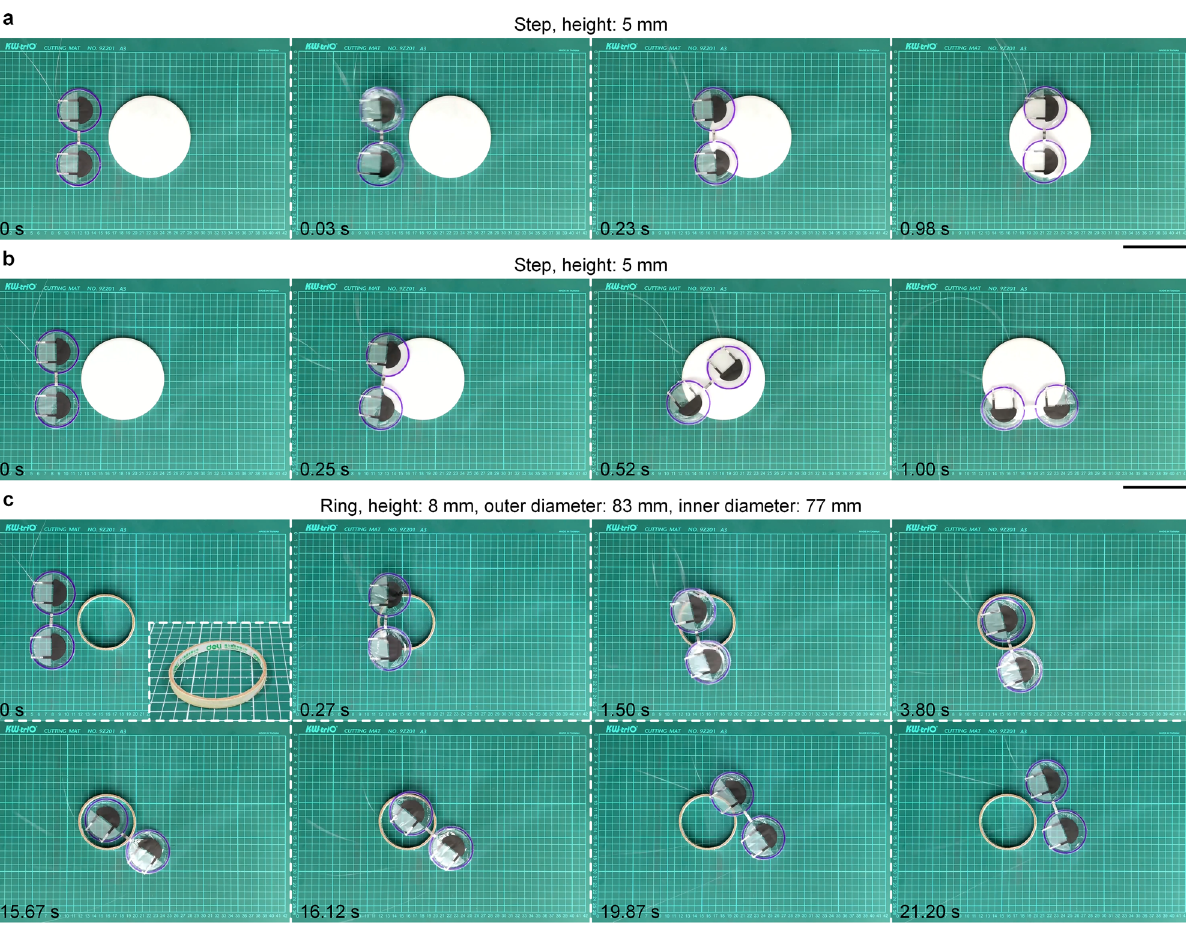
Fig. 6 Dual-body LSJR obstacle crossing. See also Supplementary Movie 6. a Straight jumping across a round step (height of 5 mm). b Steered jumping across the round step (height of 5 mm). c Jumping across a ring obstacle (height of 8 mm, inner diameter of 77 mm, and outer diameter of 83 mm). Scale bars, 10